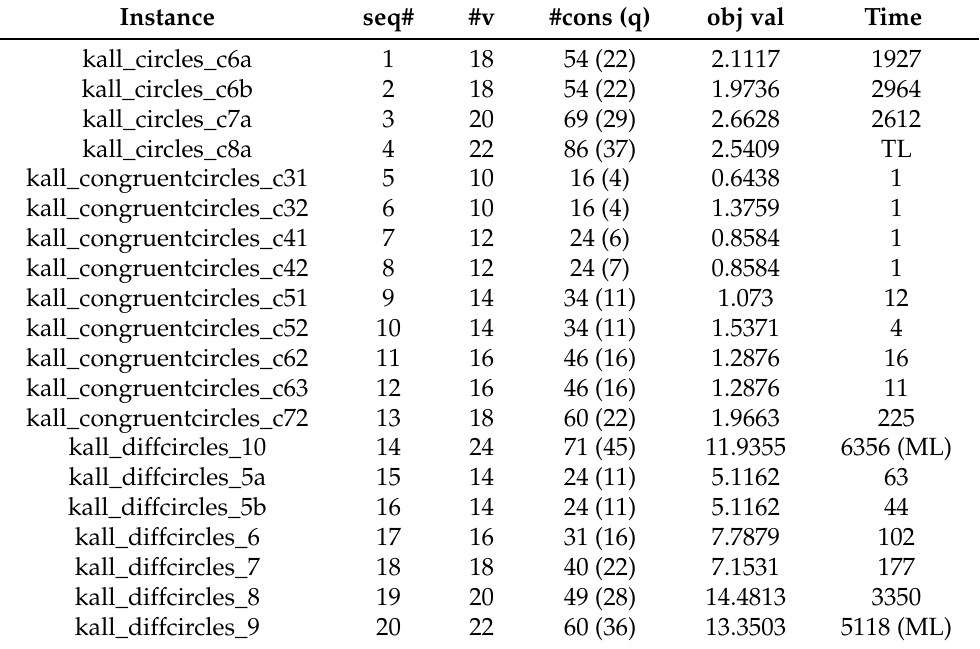
Table 1. Statistics of continuous test instances, and the solving time by SCIP.